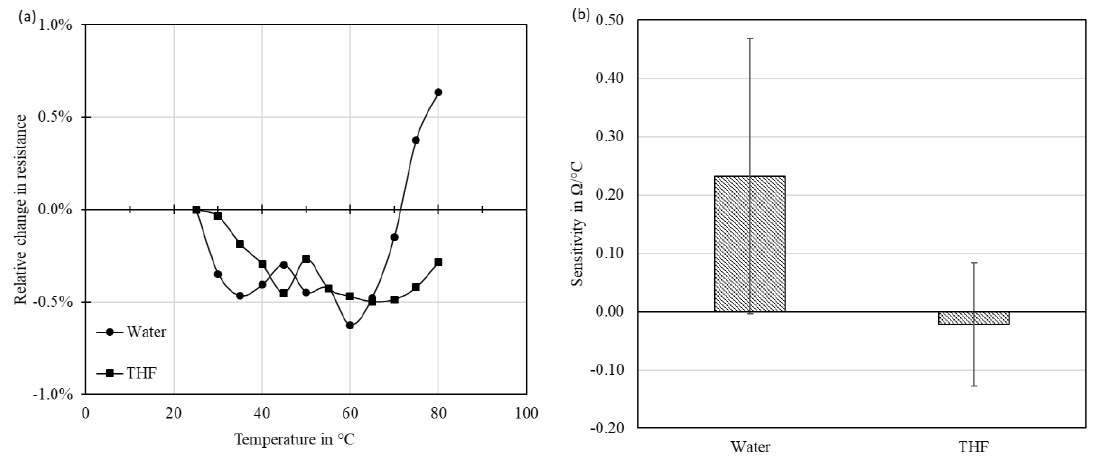
Figure 8. ( a ) Comparison of relative change in resistance between water and THF as a dispersion medium, and ( b ) sensitivity of these samples to temperature changes.